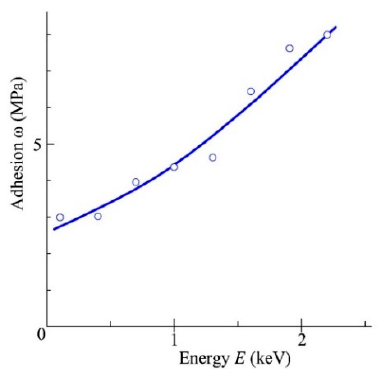
Figure 9. Dependence of the films adhesion ω on the energy E of bombarding fast atoms.